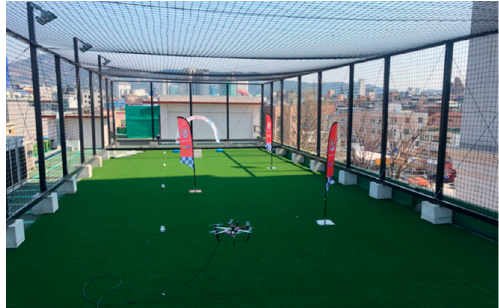
Figure 8. An experimental drone racing environment in a drone airfield.